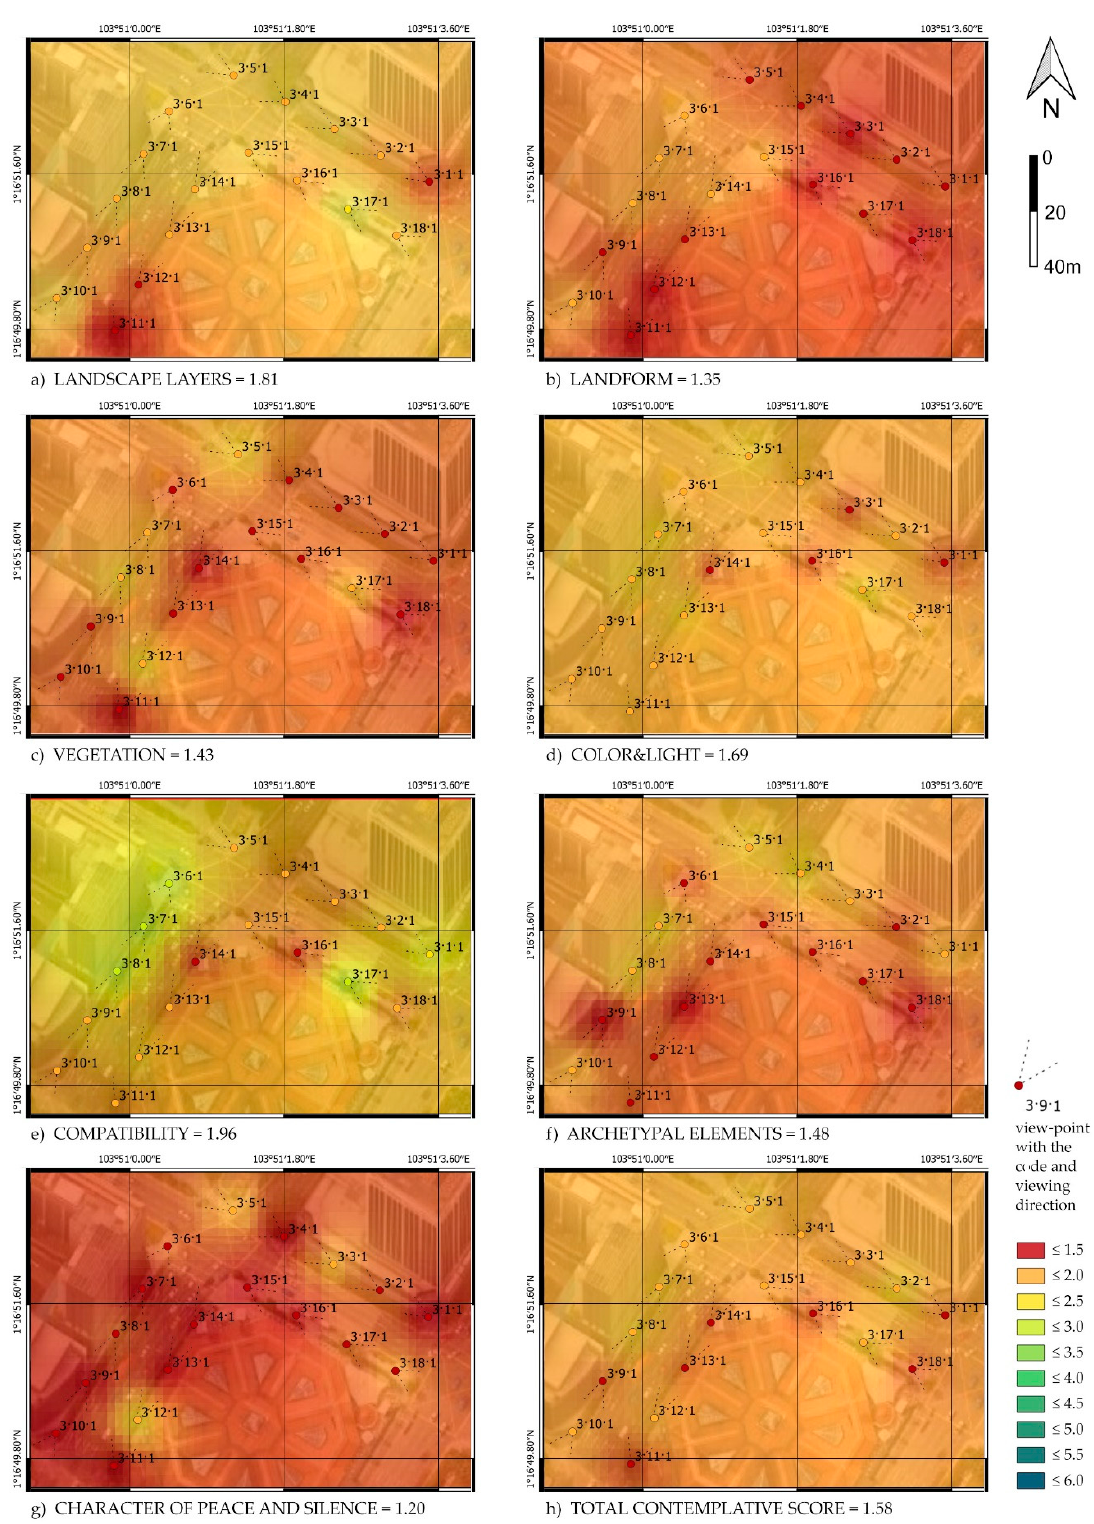
Figure 6. Result maps of contemplative scores along the Path 3–Robinson Road; walking in one direction from 3 · 1 to 3 · 18; ( a – g ) maps of each contemplative landscape attribute and ( h ) the total CL score (average of all attributes).